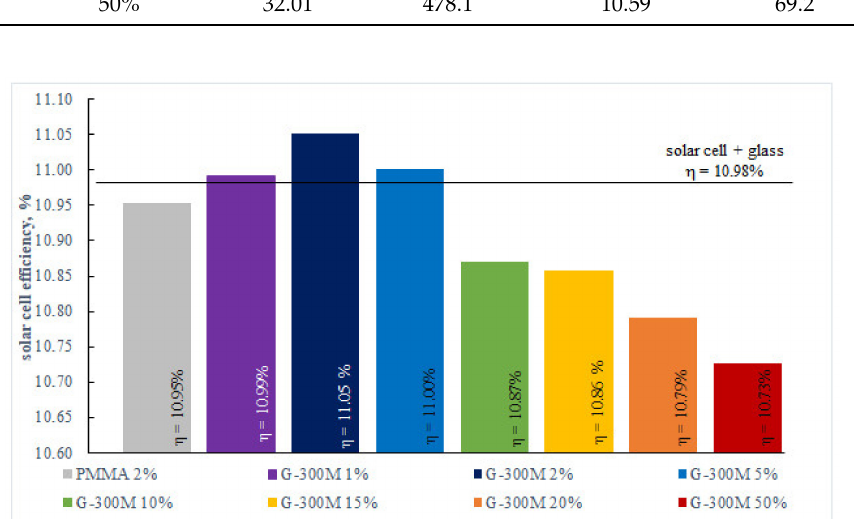
Figure 9. The efficiency comparison of G pigment in only PMMA